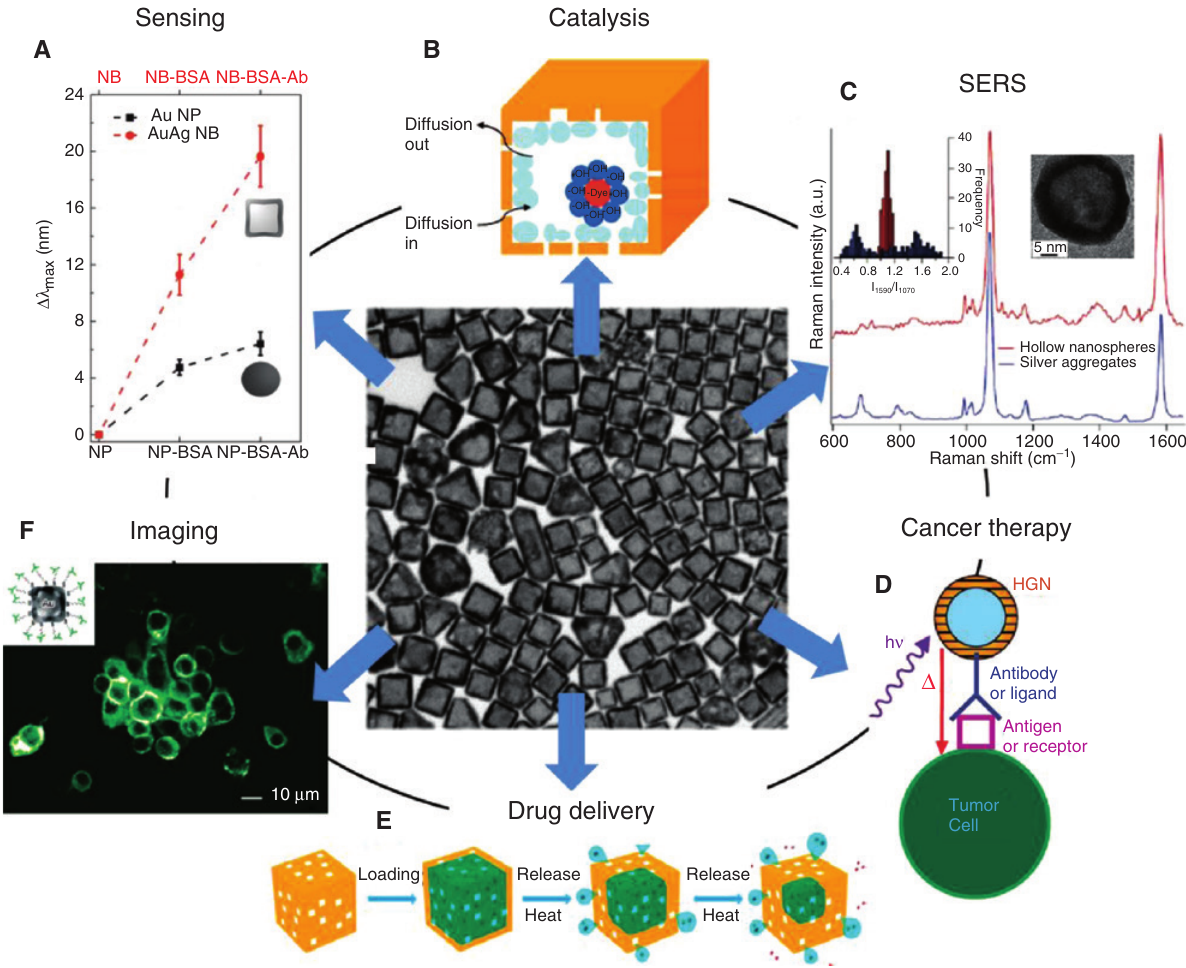
Figure 9: Various applications of hollow nanostructures. (A) Comparison of sensitivities of solid Au nanoparticles and single-walled